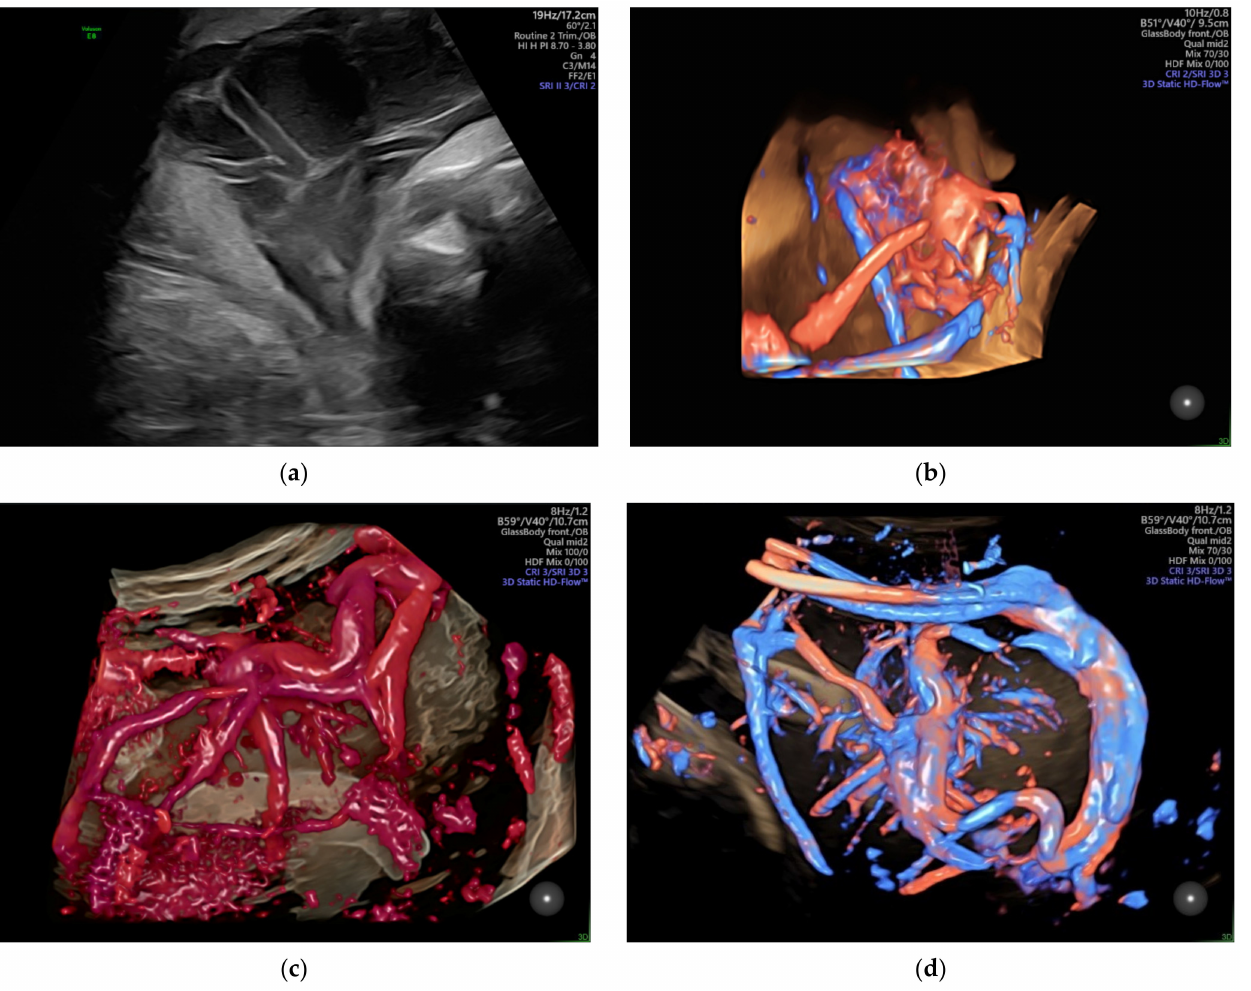
Figure 1. Velamentous cord insertion as ( a ) 2D scan and ( b – d ) 3D Static HD Flow